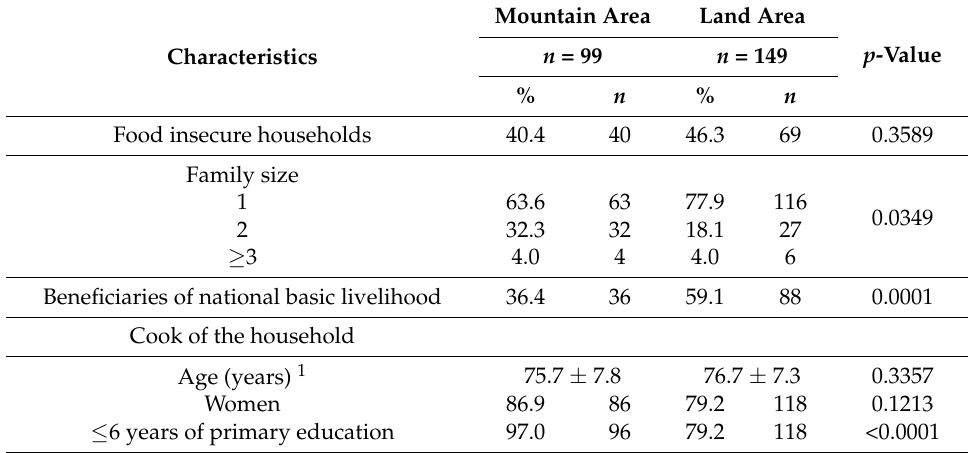
Table 1. General characteristics of households between different rural